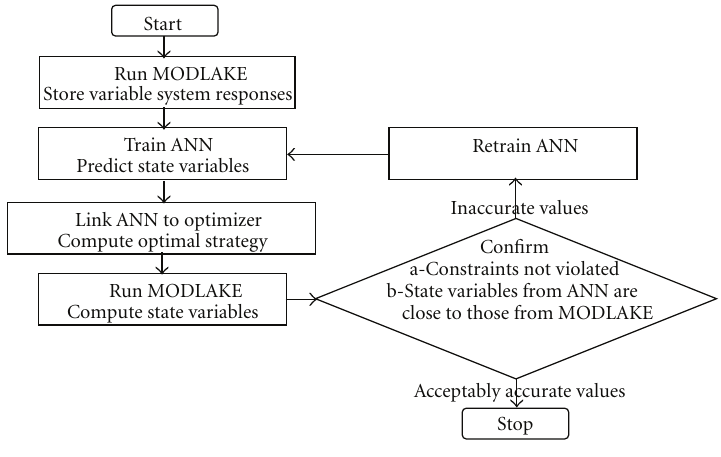
Figure 5: S-O model processing.